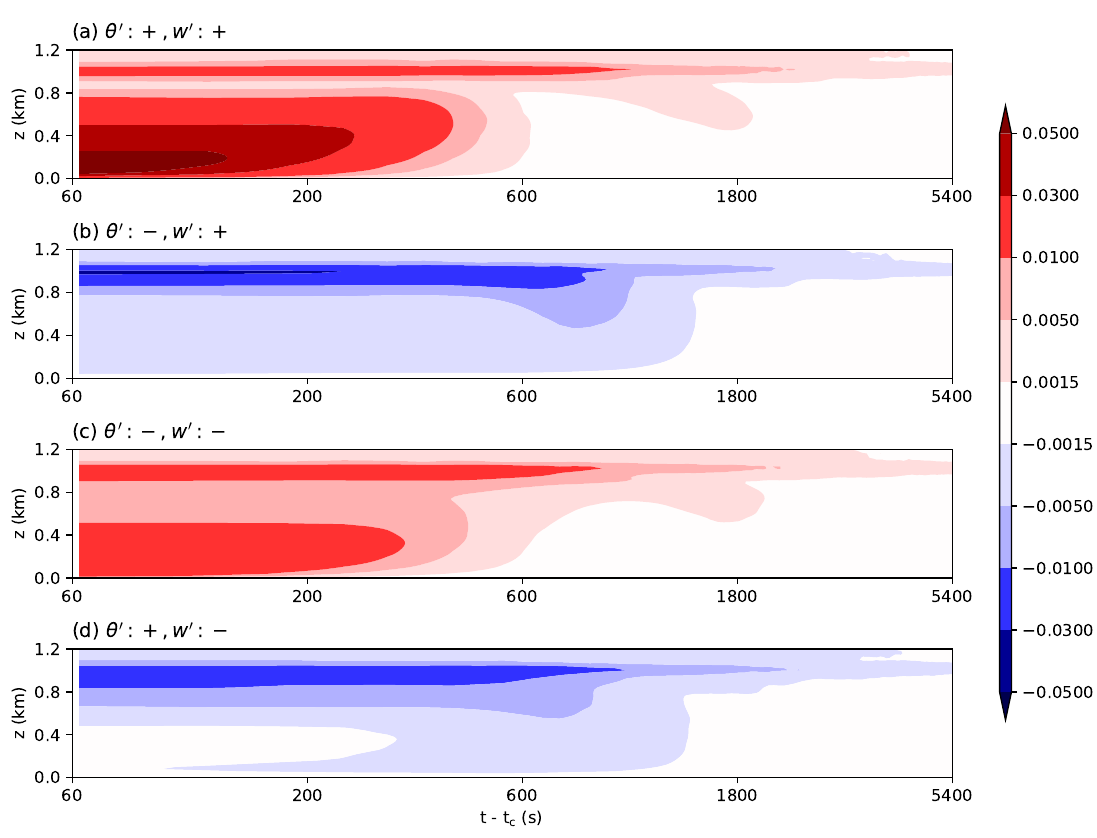
Figure 6. Time series of vertical profiles of heat flux contributions by ( a ) warm air rising, ( b ) cool air rising, ( c ) cool air sinking, and ( d ) warm air sinking quadrant events. The horizontal axis is logarithmic. Time series of the pattern correlation between the perturbations at t = t c and later perturbations illustrate the decaying characteristics in a different perspective (Figure 7). This kind of analysis is meaningful only for the free CBL because convection cells develop and decay nearly at the same place. The pattern correlation of the vertical velocity shows that convective turbulence in the middle of CBL decays slower than that near the surface or at the CBL top, as the vertical velocity variance decays (Figure 5b). The pattern correlation at z = z i /2, for instance, is higher than 0.4 at 600 s ( ∼ t ∗ ) after t = t c . The pattern correlation of potential temperature decreases more quickly than that of vertical velocity. In contrast to potential temperature, the pattern correlation of passive scalar concentration decreases slower than that of vertical velocity, implying that passive scalar has a longer memory. It is also notable that the pattern correlation of passive scalar has maximum peaks at higher levels than that of vertical velocity. This may be due to the fact that scalar perturbations have less resistance (or more inertia) in the entrainment zone than thermal and momentum perturbations, but this needs a further